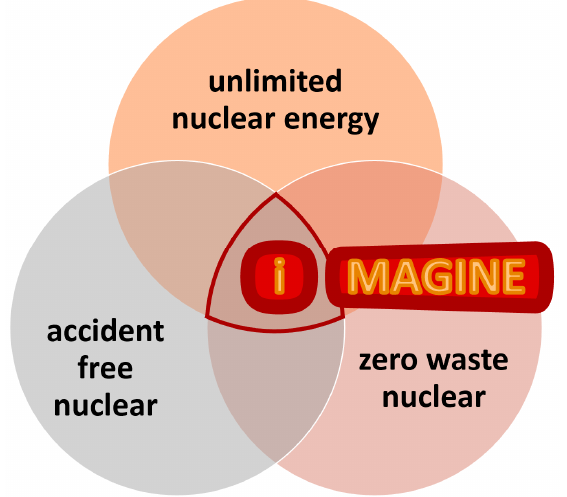
Figure 4. The ternary vision as the basis for the further development of the iMAGINE project.